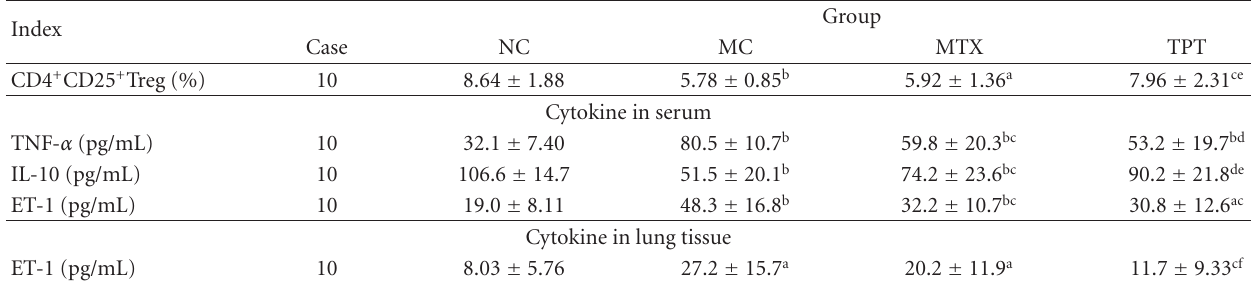
Table 2: Comparisons of regulatory T cells, cytokines, and Foxp3 in rats ( x ± s ).